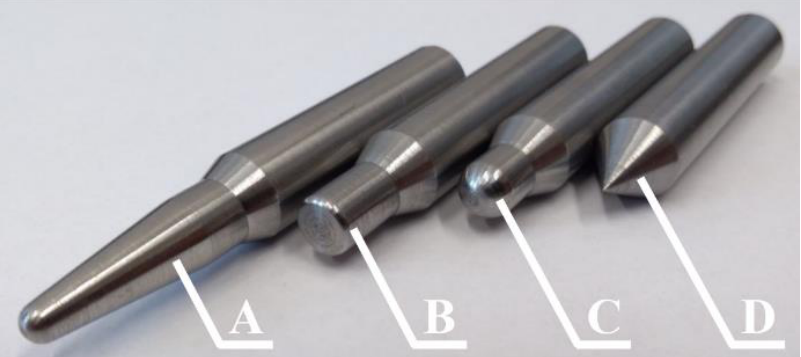
Figure 2. Strikers used in experiment: A — ogival striker, B — blunt striker, C — hemispherical striker, D — conical striker.